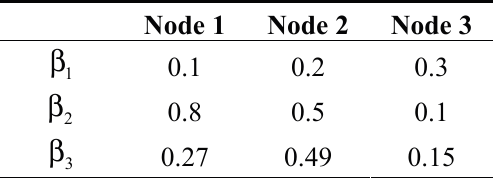
Table 3. The data after